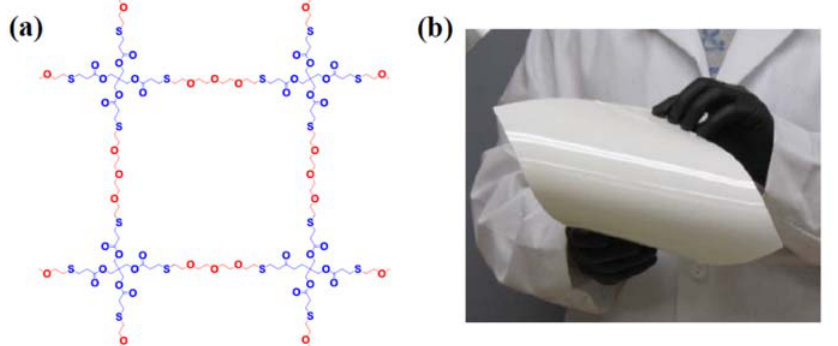
Figure 3. ( a ) Crosslinked PETTeDEGDVE polymer chain structure in the Al 2 O 3 /PEO membrane and ( b ) a photograph of the membrane (25 × 20 cm 2 ) [15].